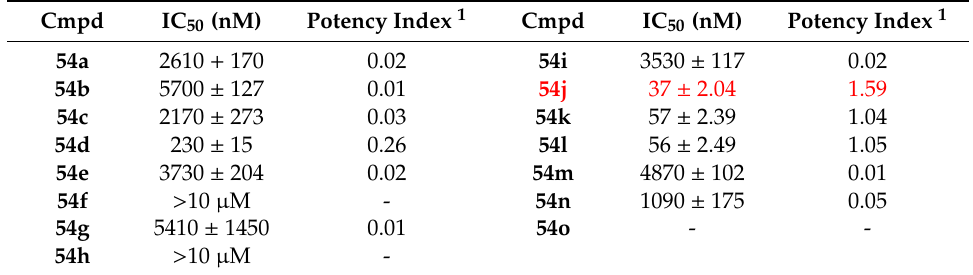
Table 6. Inhibition of Ee AChE by indenoquinolines 54a – o (data from